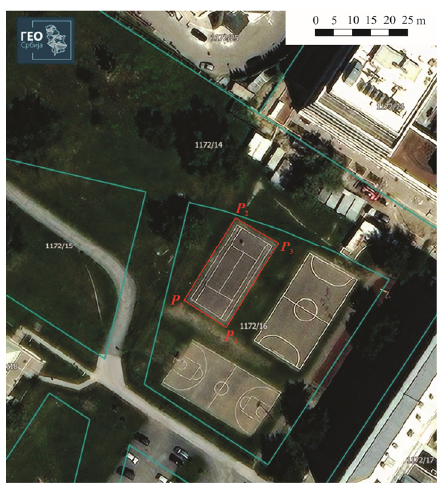
Figure 2. Test polygon. Figure 2. Test 3.1. Assigned Value and Its Uncertainty in the InterGNSS Network Comparison